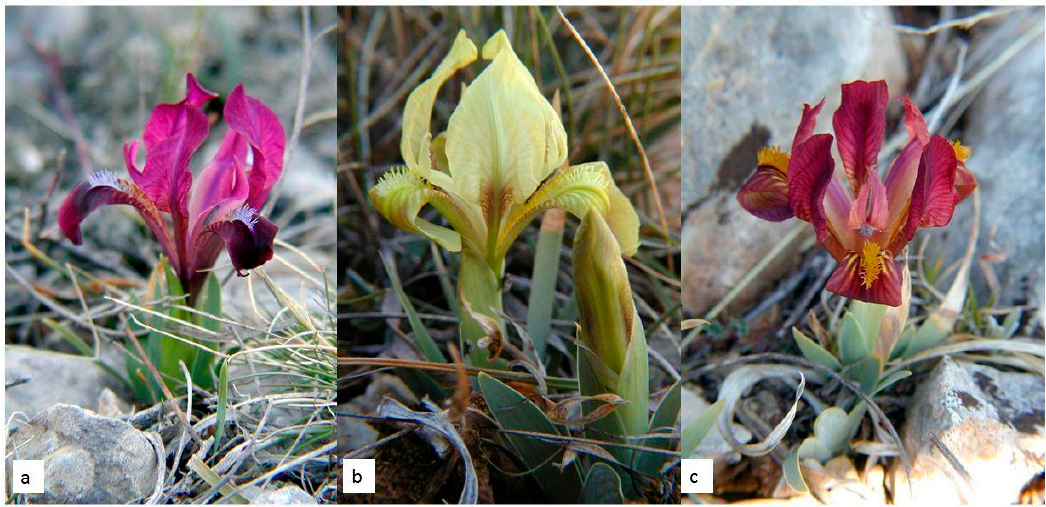
Figure 1. Narrow endemic wild Alpine-Dinaric endemic species Iris adriatica : ( a – c ) Individuals of different colours (Photo: Miroslav Miti ć ).